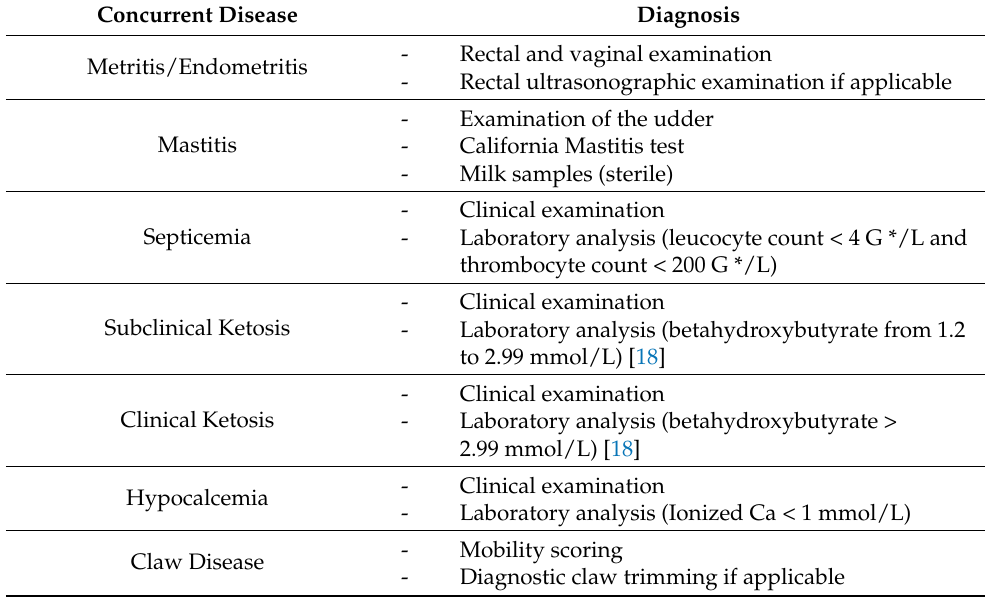
Table 2. Manner of diagnosis of concurrent diseases in 672 cows with left displacement of the abomasum (LDA) during hospitalization at the Clinic for Ruminants with Ambulatory and Herd Health Services. Due to the retrospective nature of the study, retained fetal membranes, metritis, and endometritis were summarized as metritis/endometritis. All forms of mastitis are indicated as “mastitis”. Claw pathologies are presented as “claw